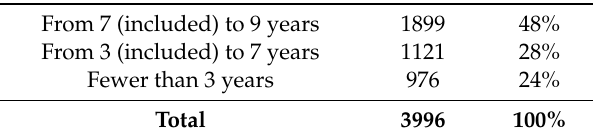
Table 5. Artists’ inclusion in the galleries’